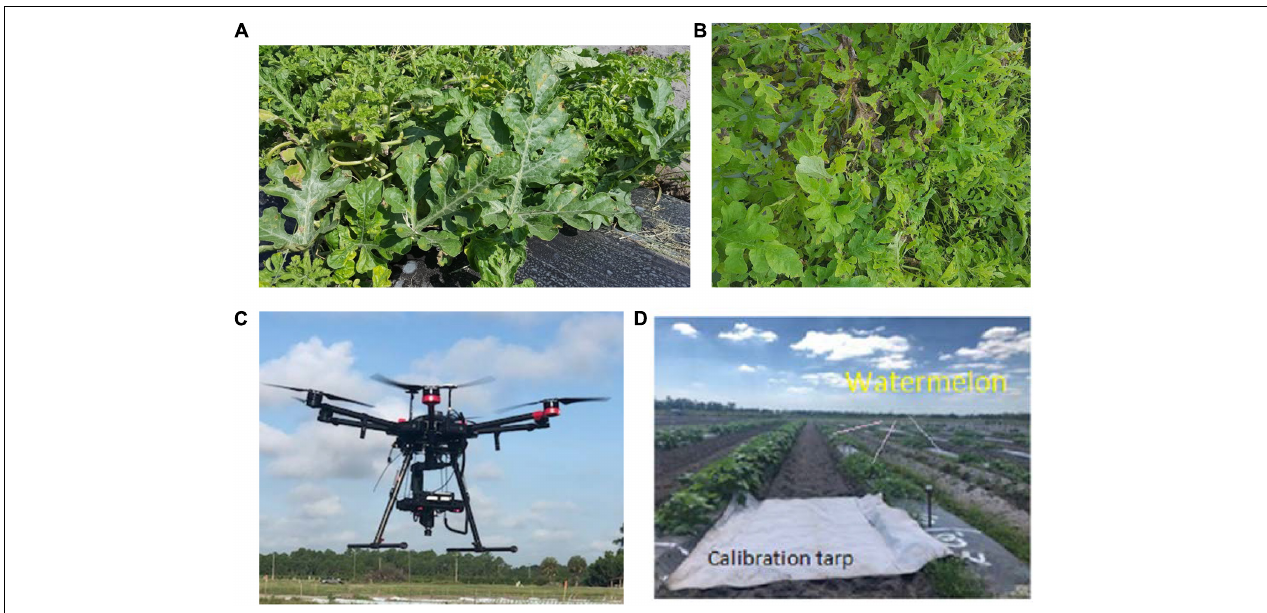
FIGURE 2 | Downy mildew severity stages in the field: (A) low; (B) high; (C) UAV-based hyperspectral imaging system; and (D) a calibration